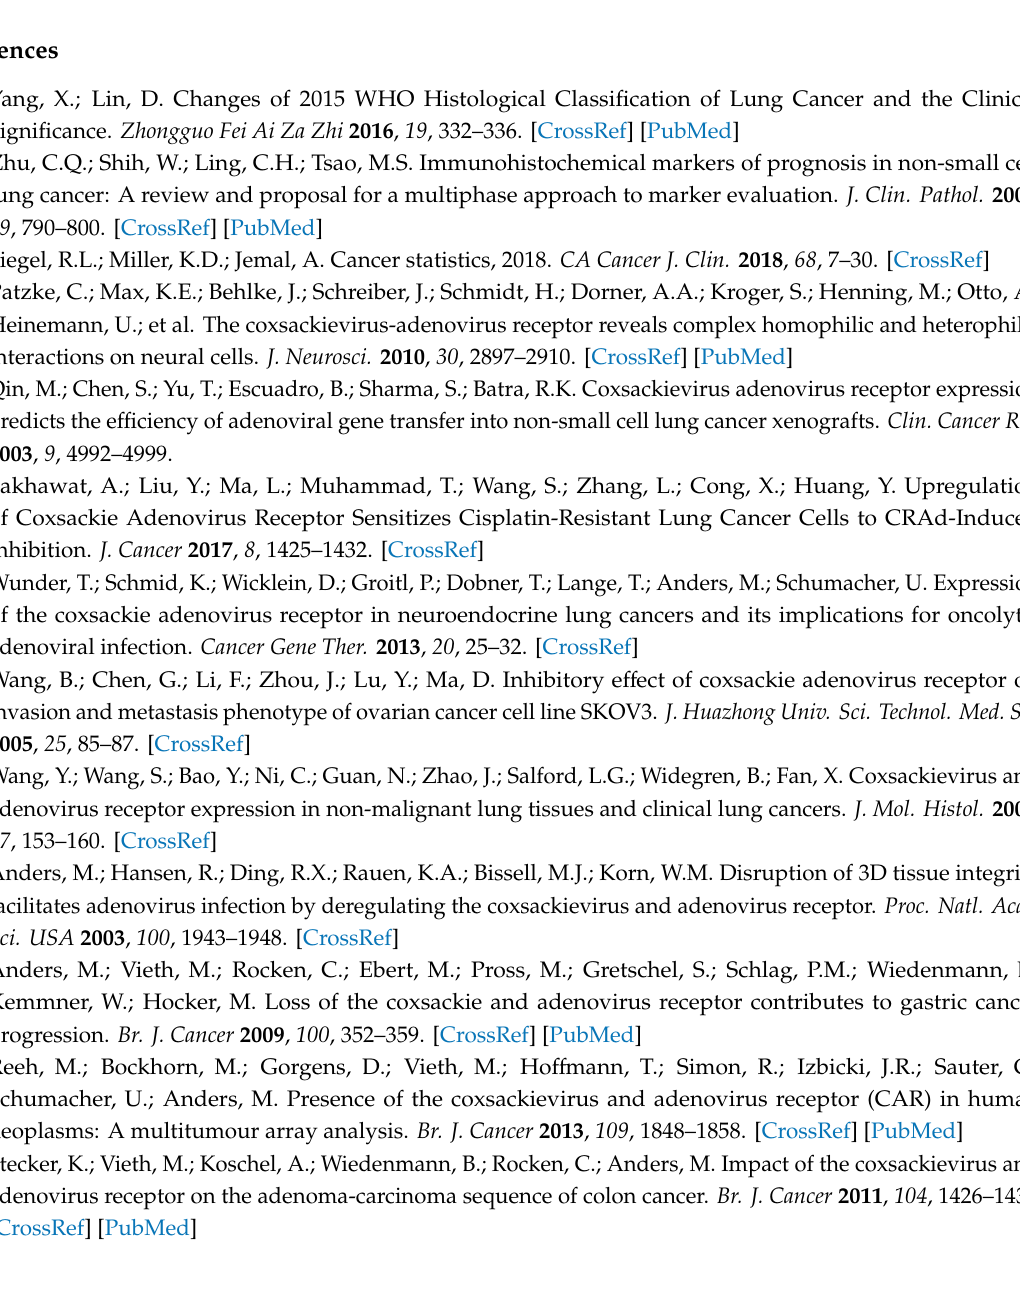
Table S1: List of GEO datasets. Table S2: Gene names. Figure S1: Analysis flow of identification two groups of genes on CAR sequential changes from NL, atypical adenomatous hyperplasia (AAH), to invasive LUAD. Figure S2: The impacts of expression level of (A) CAR and (B) DSG2 on survival in early stage disease (Stage I and IIA) and late-stage disease (Stage IIB, III, and